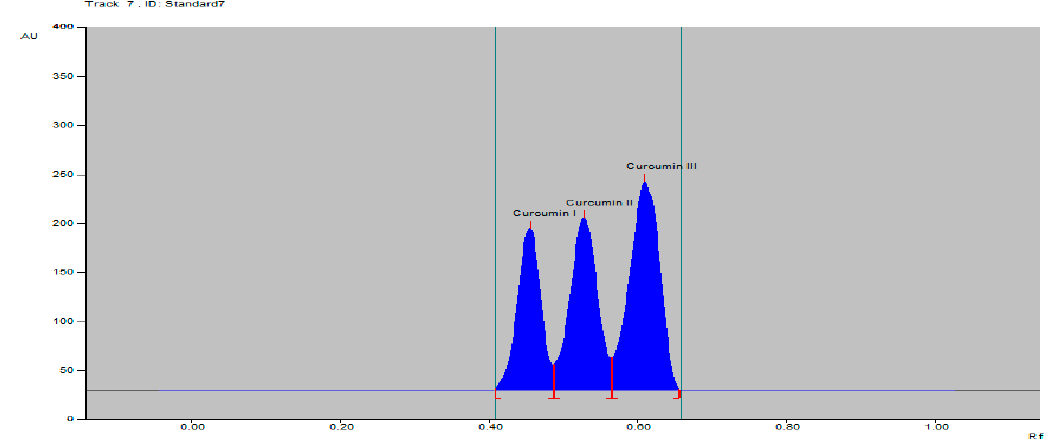
Figure 2. HPTLC densitogram of standard curcumins I–III.